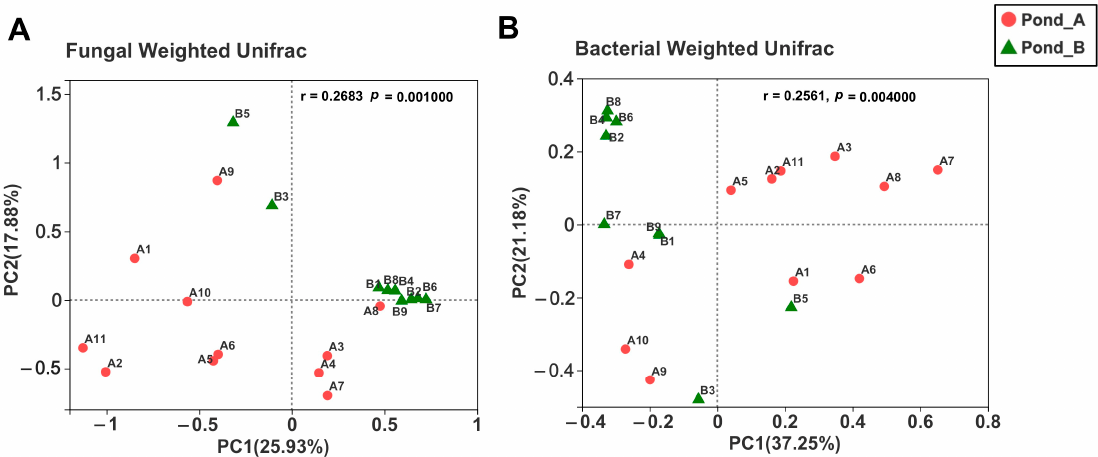
Figure 8. Principal coordinate analysis plots of fungal ( A ) and bacterial ( B ) communities in two hot spring ponds based on weighted Unifrac distance. The r and p -values of the analysis of similarity were shown respectively in each figure ( p < 0.01). Regression curves showed the relationships between sediment pH and OTU richness (Figure 9). No significant correlation existed between pH and overall fungal (R 2 = 0.0044, p = 0.7814, Figure 9A) and bacterial OTU richness (R 2 = 0.0067, p = 0.7316, Figure 9B). However, we noticed a significant correlation between pH and the richness of